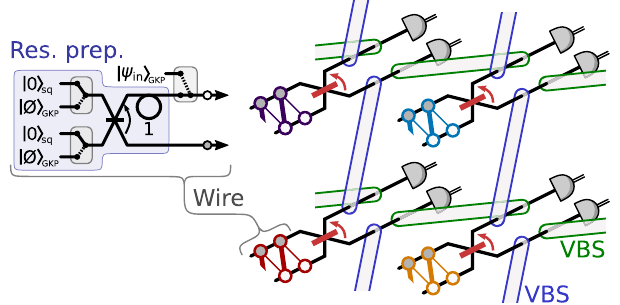
FIG. 1. Conceptual illustration of the computation